Question: Which visualization type does this figure use?
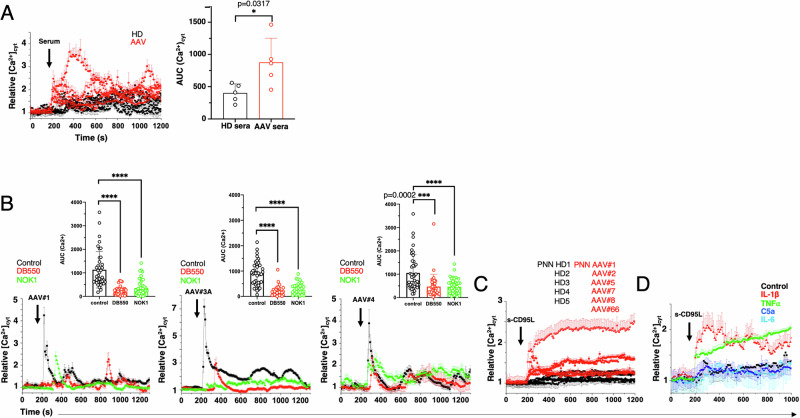
Answer: histogram